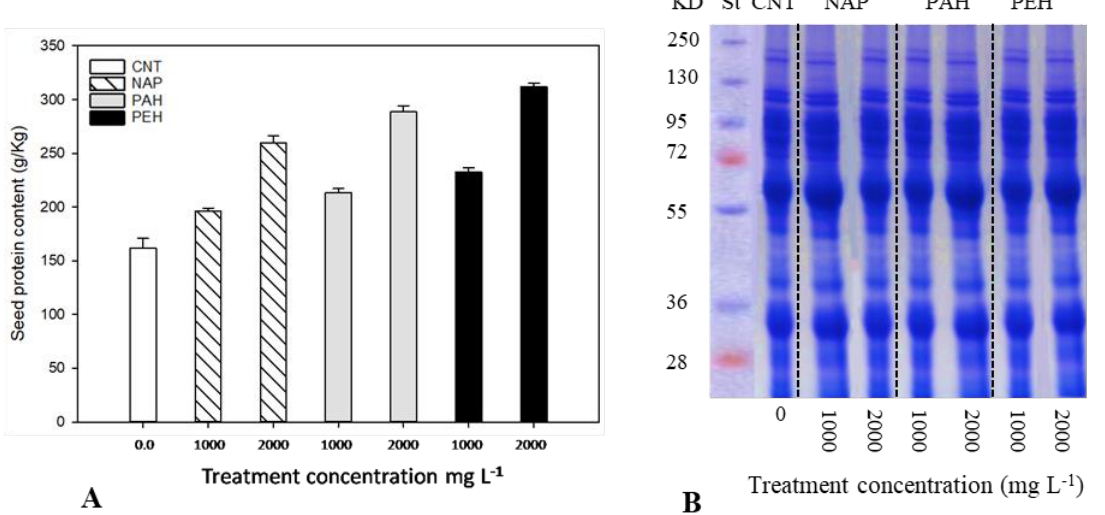
Figure 3. Protein content ( A ) and SDS-PAGE ( B ) of Pisum sativum plants under normal clay loam soil conditions treated with foliar spray of native whey protein (NAP), papain-hydrolysed whey protein (PAH) or pepsin-hydrolysed whey protein at two different concentrations; 1000 and 2000 mg L − 1 , as compared to normal control (CNT). St; Protein standard.